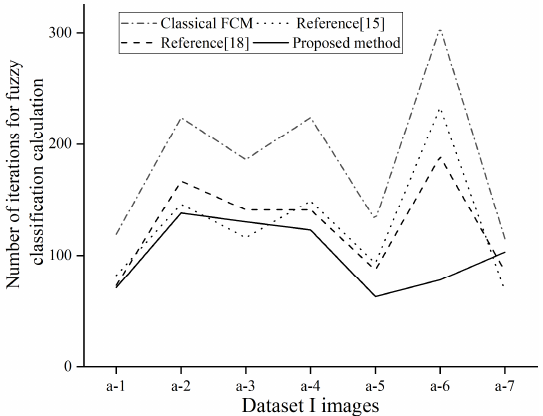
Figure 10. Number of iterations of eye image segmentation.